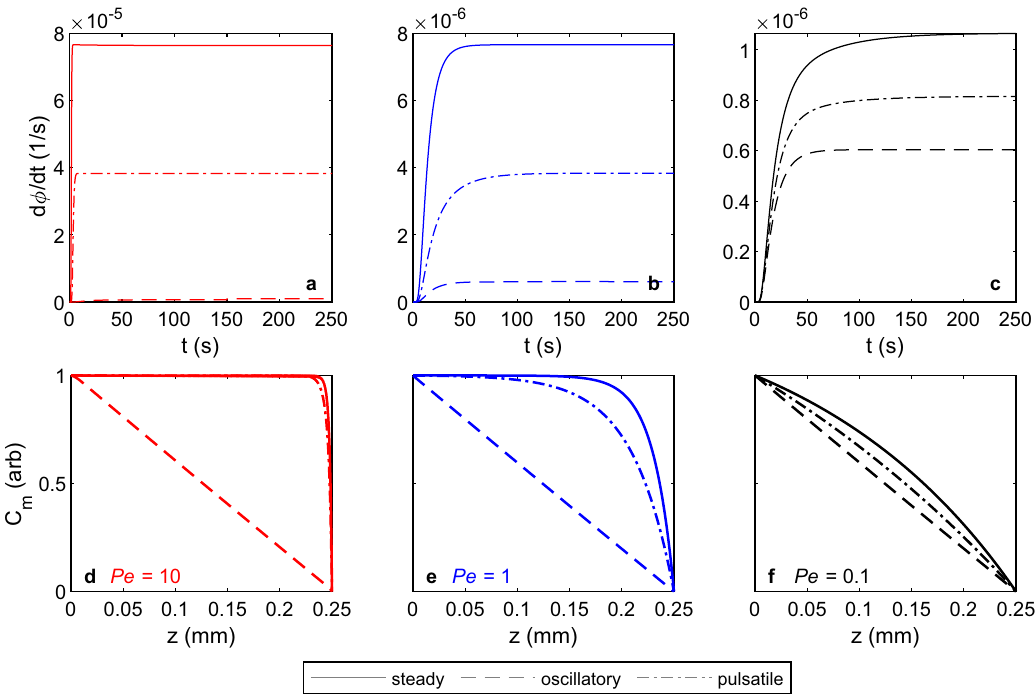
Figure 6. ( a – c ) Rates of normalized solute mass efflux from the domain in the source-sink simulations and 250 s) for flows with ( a , d ) Pe = ( d – f ) radially-averaged asymptotic solute concentration profiles (plotted at t = 10, ( b , e ) Pe = 1, and ( c , f ) Pe = 0.1. Flux was calculated across the mid-plane of the domain and, by conservation of mass, must be equal to the efflux from the domain in the asymptotic state. Increasing Pe leads to greater rates of solute efflux for steady, pulsatile, and oscillatory flows, as well as a greater difference between concentration profiles for oscillatory and steady/pulsatile flows. The profiles shown in ( d – f ) can be compared to the sketch in Fig. 1c, which illustrates diffusion-dominated transport. Animations that include panels ( d – f ) are provided in Supplementary Videos 4, 5 and 6,